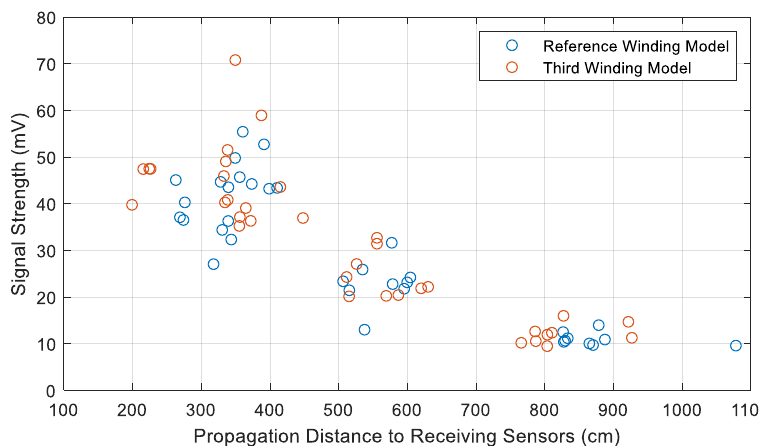
Figure 10. Comparison of signal attenuation between the reference and third winding designs at different propagation distances with the source at position W3.